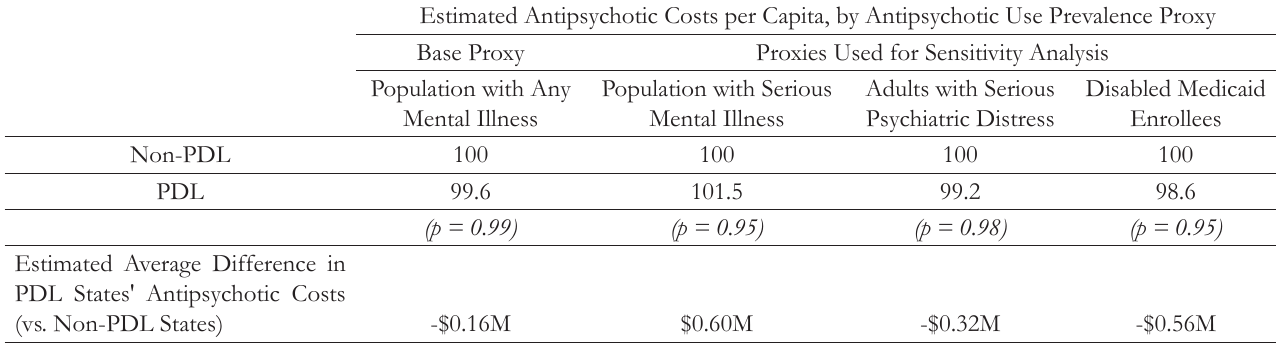
Table 4. Estimated Antipsychotic Costs Per Capita, by State Medicaid Antipsychotic Category Management